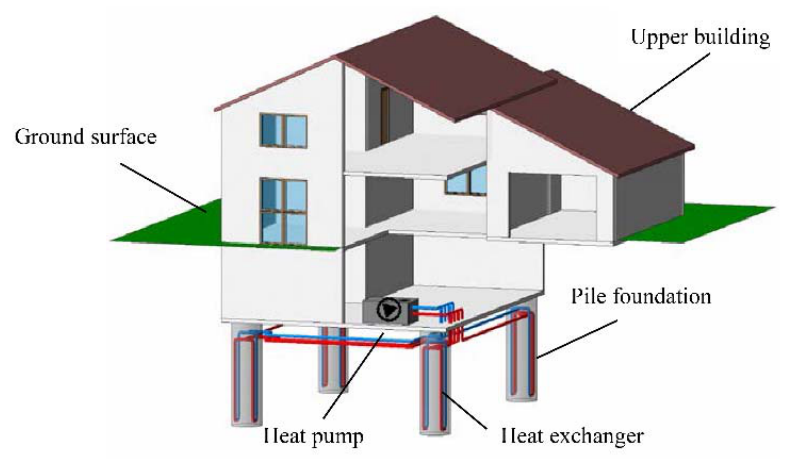
Figure 1. The geothermal energy pile system.